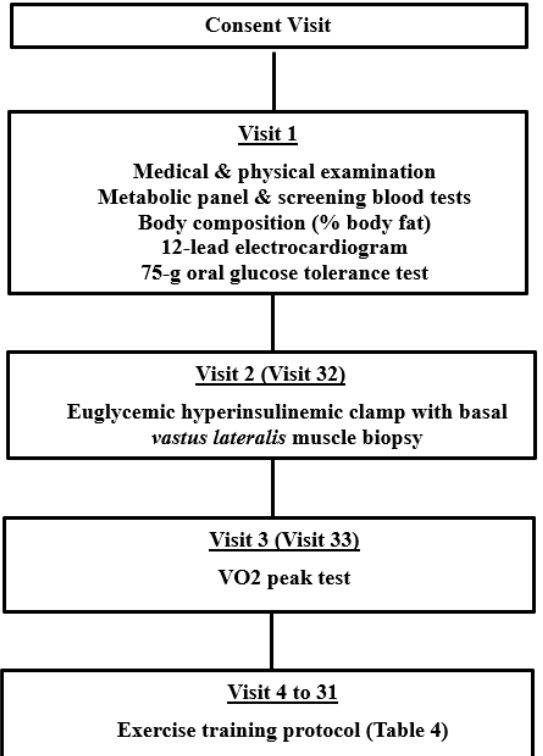
Figure 5. Outline of study design and